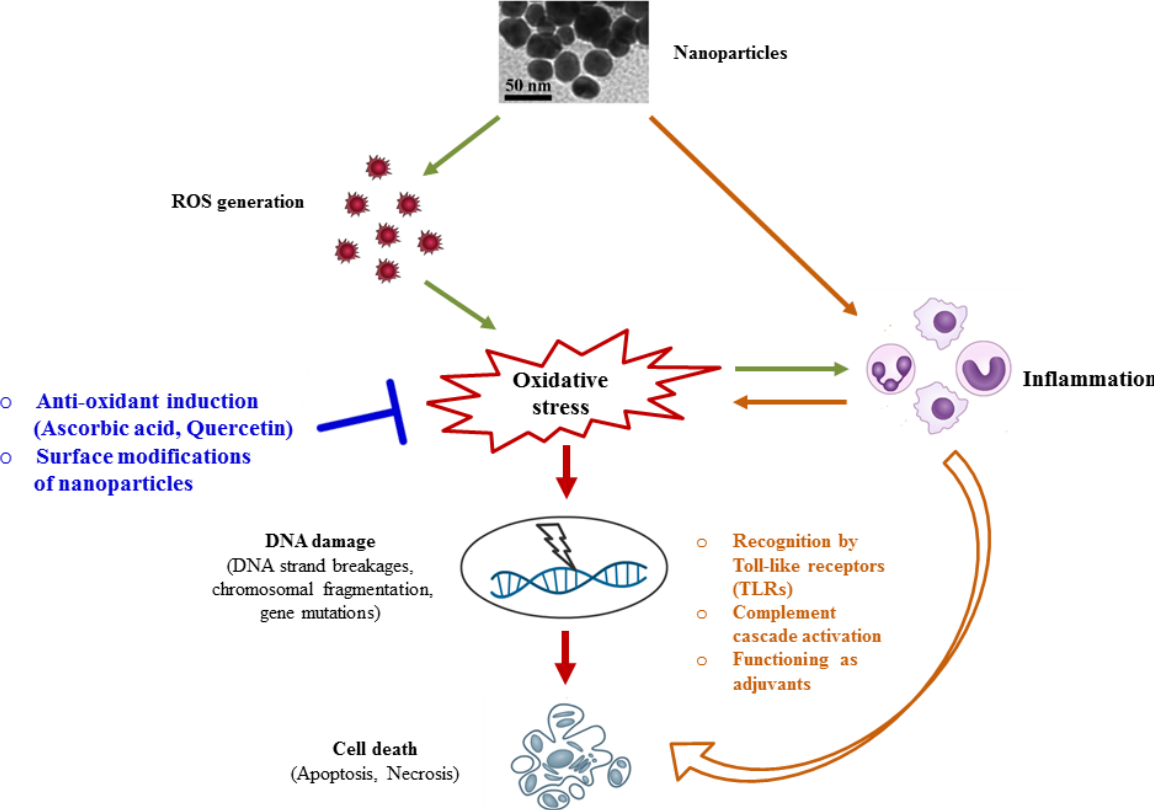
Figure 1. Overview of the signaling cascades mediating nanotoxicity, and possible strategies to circumvent the